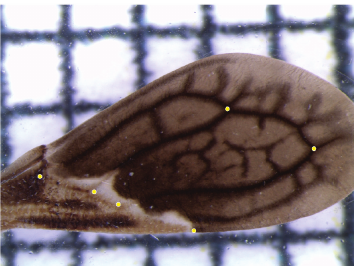
Figure 1: Six landmark positions on the left wing of B. ferroae used in this